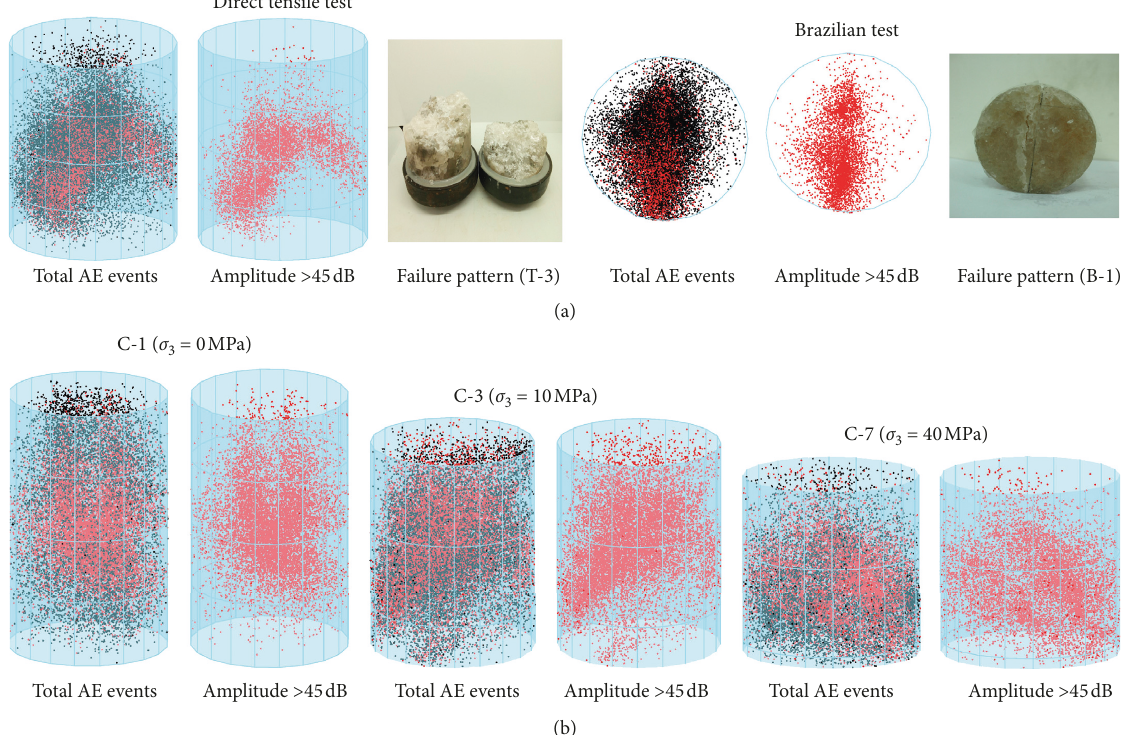
Figure 9: Spatial distributions of total AE events and AE events with amplitude > 45dB. (a) Tensile test. (b) Compression test.